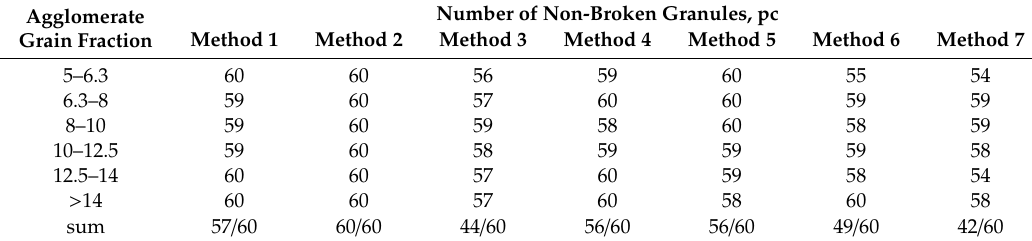
Table 4. Number of non-broken